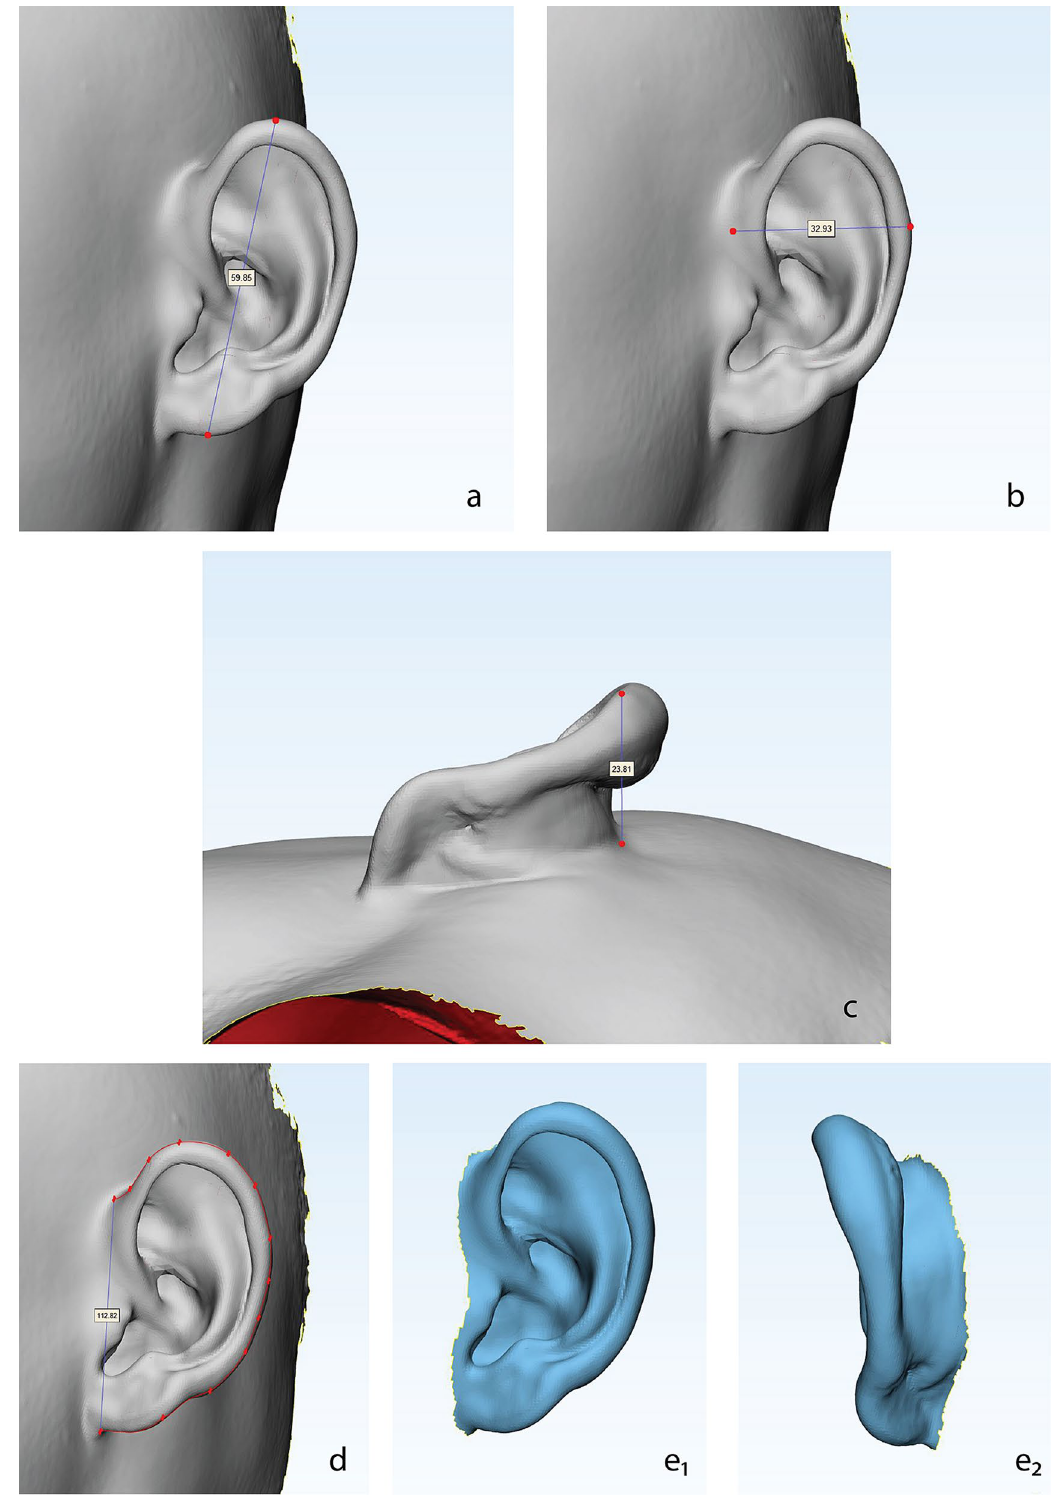
Figure 6. Five factors of the normal auricle measured in this study, including ear length ( a ), ear width ( b ), ear projection ( c ), ear perimeter ( d ), and ear surface area (front e 1 and back e